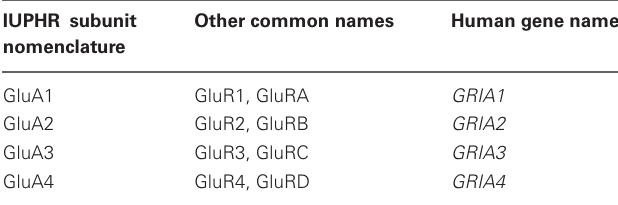
Table 1 | Nomenclatures of AMPAR